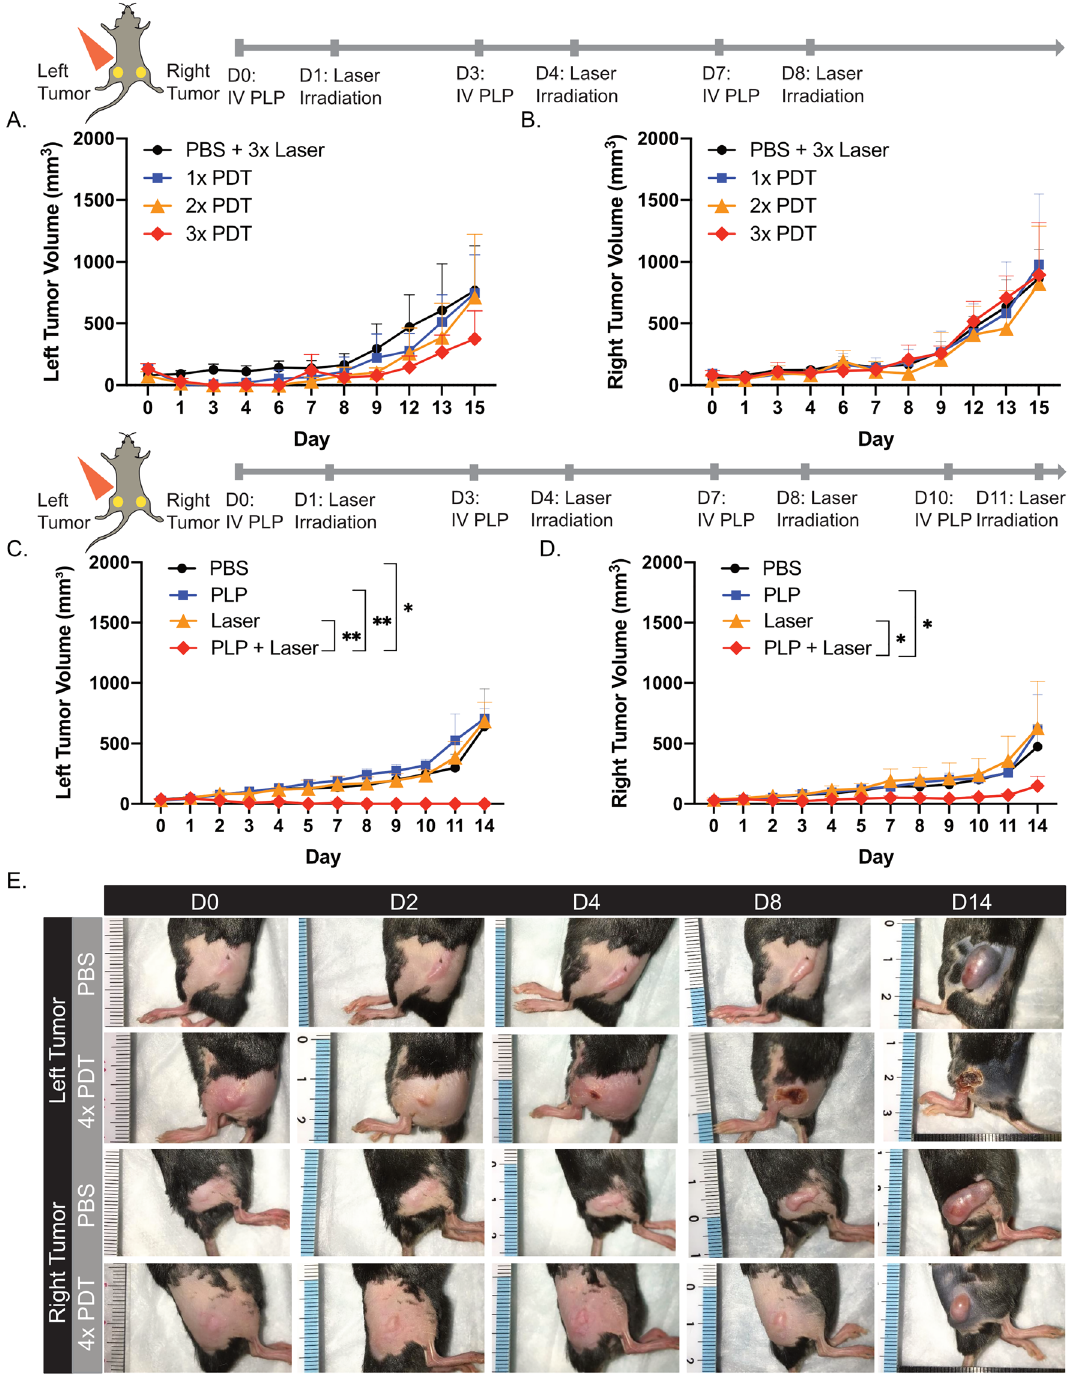
Figure 4: Four repeated cycles of PDT induced an abscopal effect. (A) DualsubcutaneousAE17-OVA + tumor bearingmiceweretreatedwitheitherPBS andlaser irradiationat 50J/cm 2 threetimes( n =6),or PLP and laser irradiation at 50 J/cm 2 one ( n = 5), two ( n = 6), or three times ( n = 5). Evaluation of irradiated, left hindlimb tumor volumes. (B) Assessment of nonirradiated, right hindlimb tumor volumes. (C) Dual subcutaneous AE17-OVA + tumor bearing mice were treated with four cycles of PBS, PLP (4 mg/kg), laser irradiation at 50 J/cm 2 , or PDT (PLP + laser). Tumors for irradiated, left tumor volumes were measured. (D)Nonirradiated, righthindlimbtumorvolumesweremeasured ( n =4). (E)Photosof left,irradiatedandright,nonirradiatedhindlimbtumors of mice treated with either PBS or four cyclesof PDT on days 0, 2, 4, 8, and 14. Experiments were repeatedtwice more with similar fi ndings for left and right hindlimb tumor volumes. Data are mean ± standard deviation. Statistical signi fi cance was determined using a one-way ANOVA followed by a post hoc Tukey test. *p < 0.05, **p <